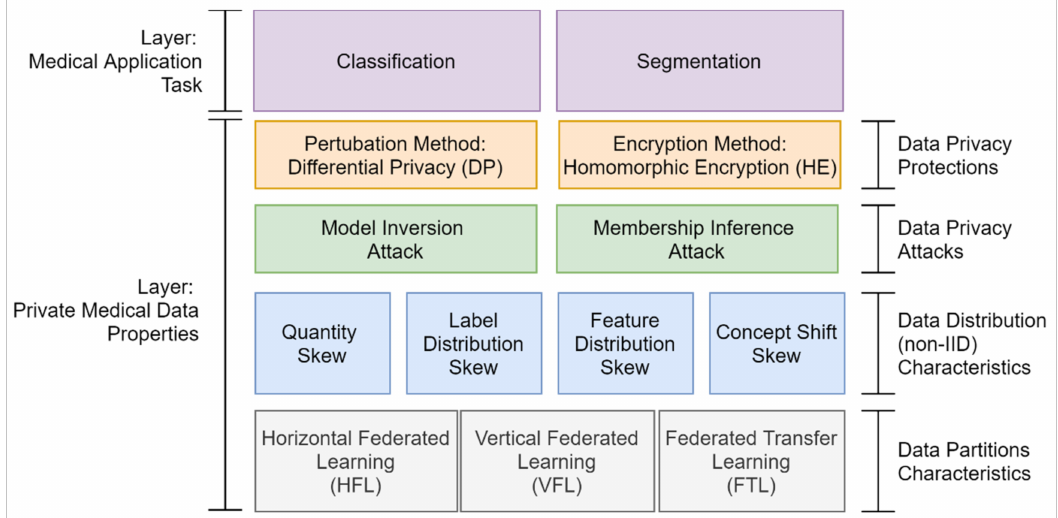
Figure 3. Medical data properties in federated learning for medical applications, consisting of data partitions, data distribution (i.e., non-IID) characteristics, possible data privacy attacks, and data privacy